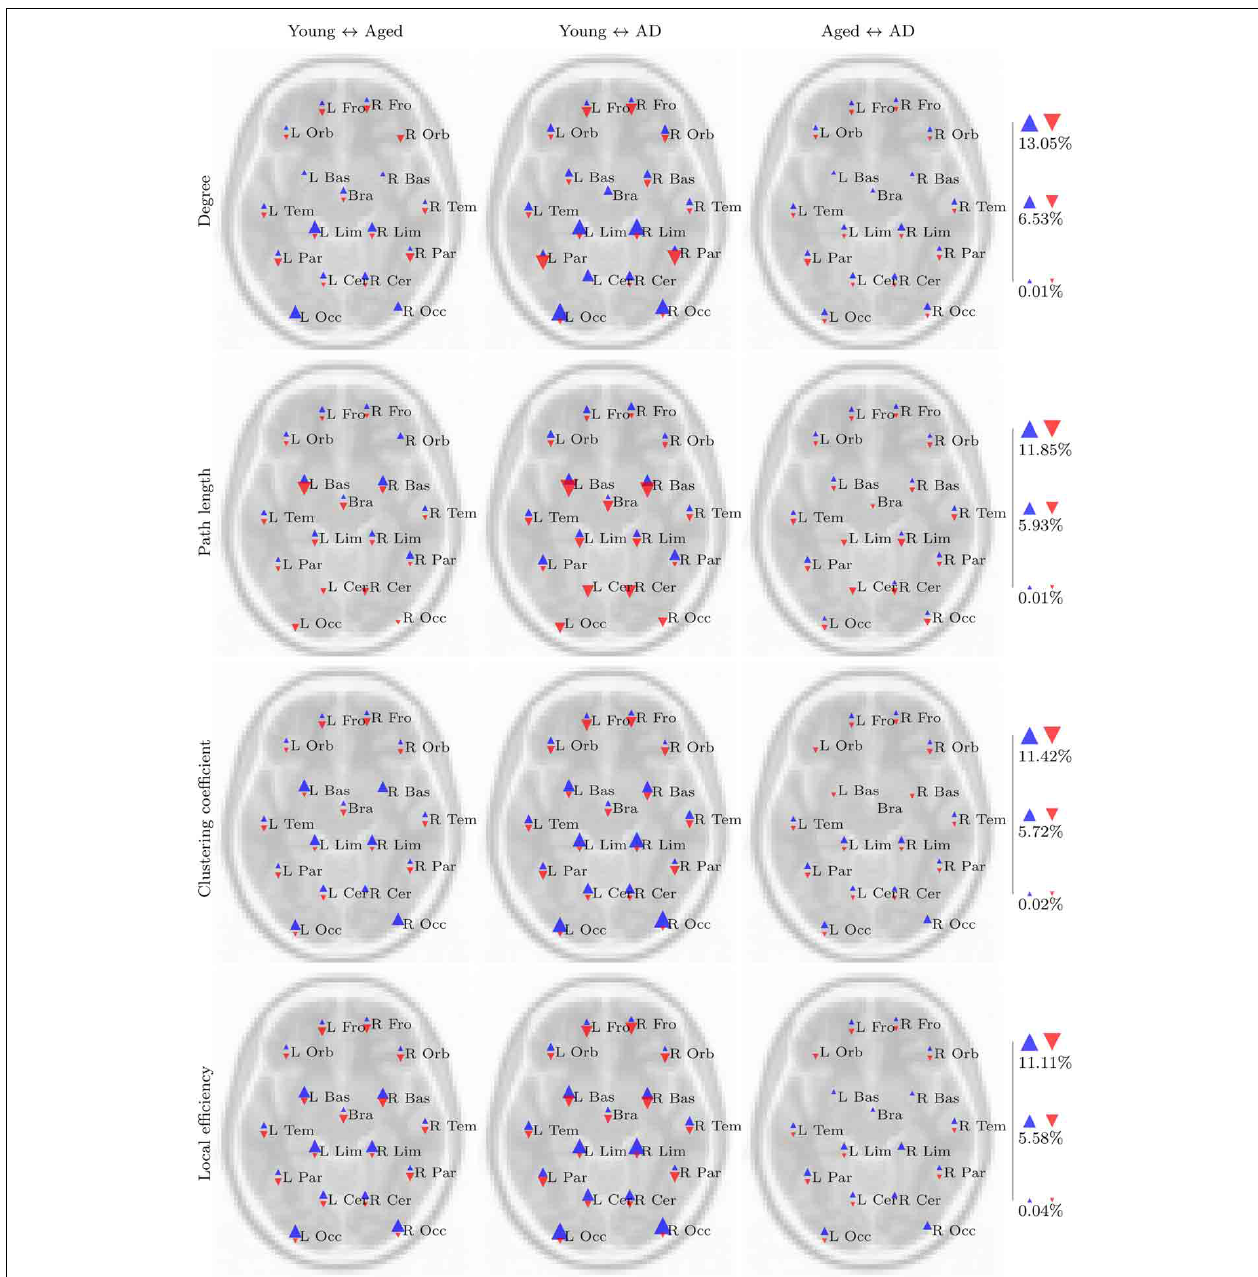
FIGURE 5 | Summary of regional group differences in task based networks. The images display the total proportion of voxels for each region, normalized by region size, in which a significant difference in the respective network measure was observed between each pair of groups, in both fMRI and standard space, across all correlation thresholds. The region labels are based upon a reduced version of the LPBA40 anatomical atlas (Mazziotta et al., 2001; McCarthy et al., 2013). Blue triangles pointing upwards reflect